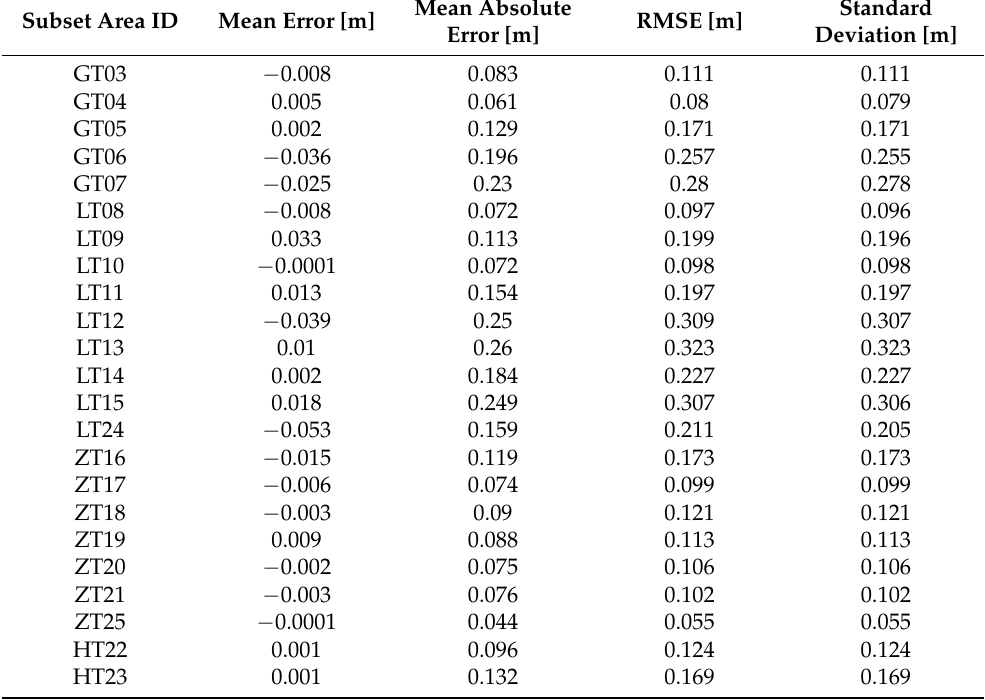
Table A1. Statistical measures of the DoD for the different subsets. Subset Area